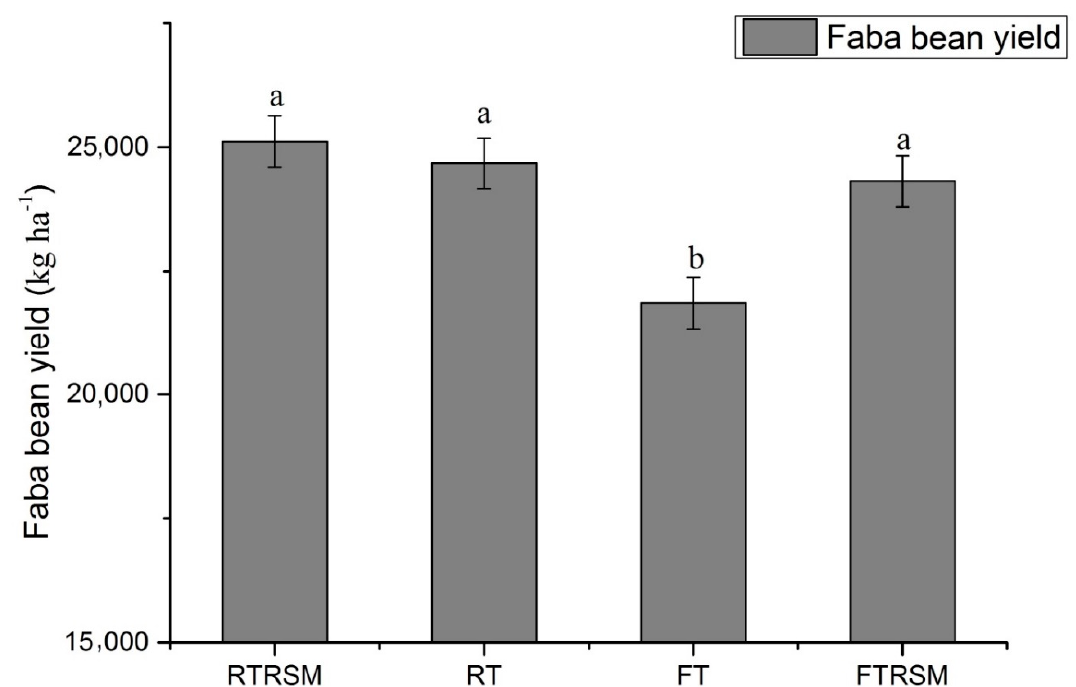
Figure 5. The yield of faba bean under different treatments. FT. flat tillage without any mulch; FTRSM, flat tillage with rice straw mulched; RT. ridge tillage without any mulching; RTRSM, ridge tillage with rice straw mulched. Different lowercase above histogram indicates significant difference between treatments. Table 6. The agronomic characteristics of faba bean under different treatments at harvesting period.